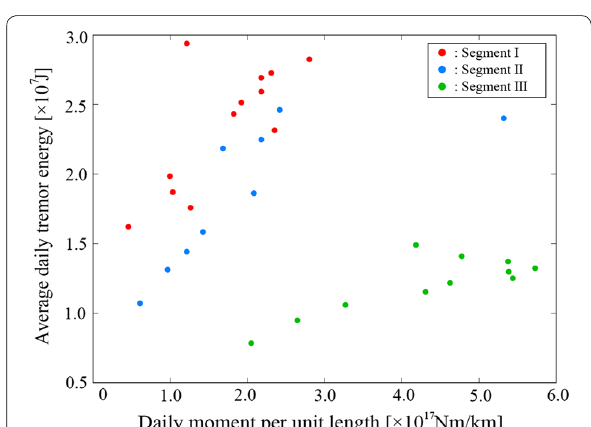
Fig. 7 Relation between the daily moment of the estimated fault per unit length and the average daily tremor energy. The horizontal and vertical axes indicate the daily moment per unit length of the estimated fault and the average of daily tremor energy during the release period, respectively. Each plotted data correspond to different threshold of the tremor energy. Data are plotted only for the ‘well-fitted models’ defined in the main text in each segment. Red, blue, and green dots indicate segments I, II, and III,